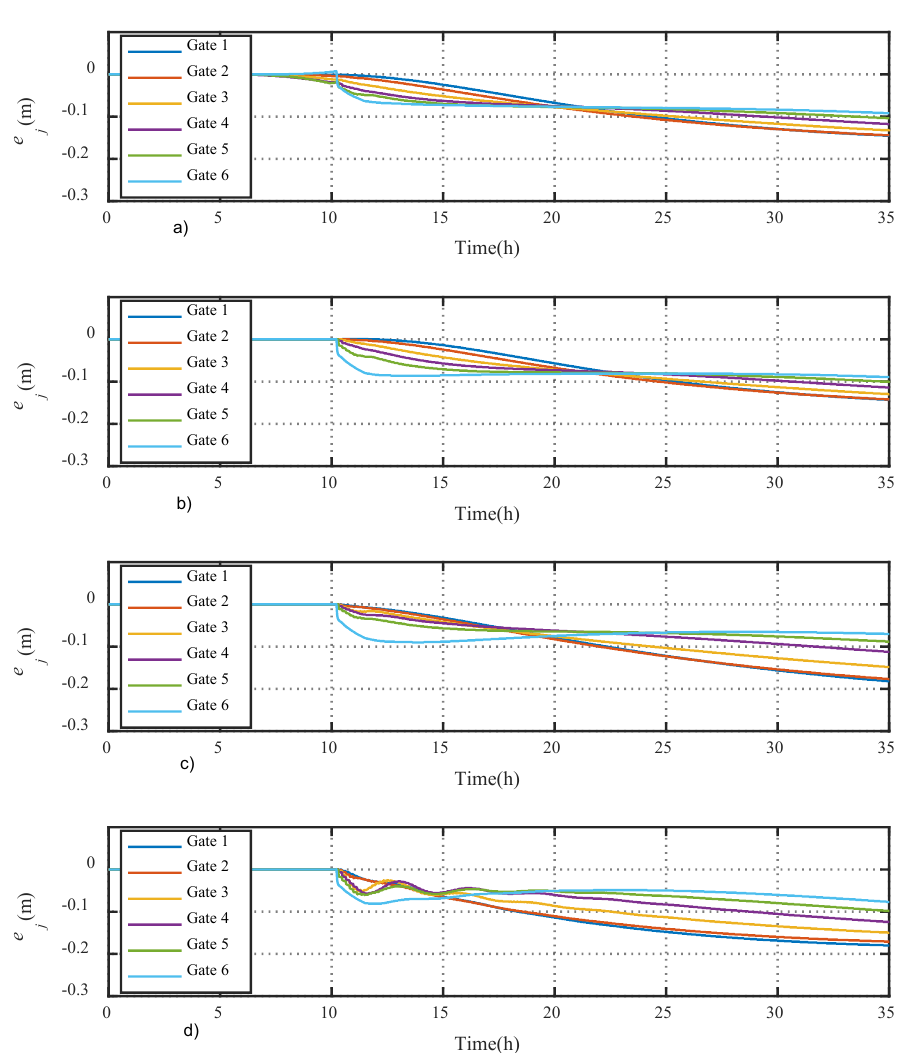
Figure 2. The simulation water level deviation result for scenario No. 1 with model predictive control (MPC-I) control ( a ), MPC-I control ( b ), linear quadratic regulator (LQR) I ( c ), and LQR II ( d ).